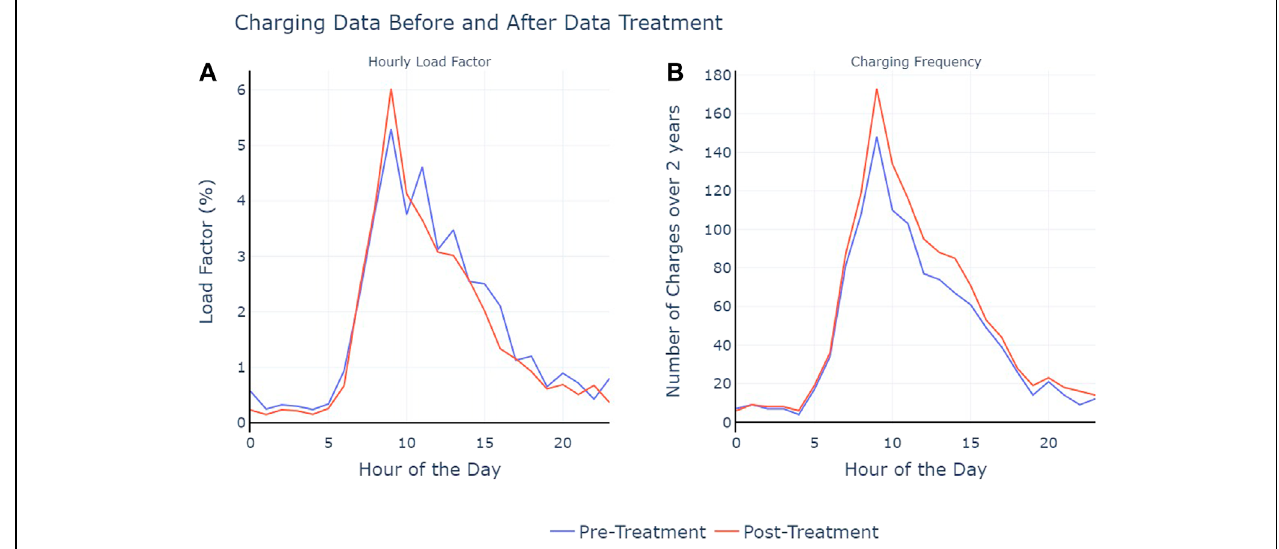
FIGURE 5 | Analysis of charging data before and after data processing (A) : the mean hourly charging power and (B) : the frequency of charging before and after data